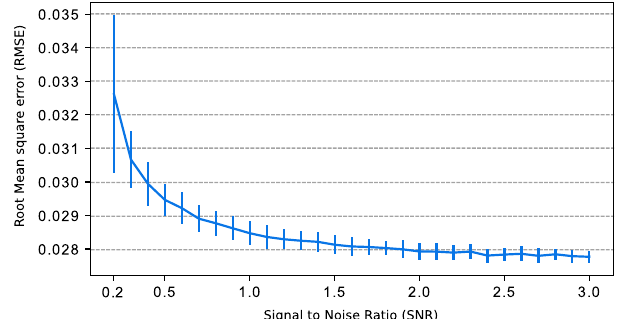
Figure 5. Graph of the Root Mean Square Error (RMSE) and standard deviation (vertical bars) for SNR levels from 0.3 to 3. The mean and standard deviation of the RMSE was taken from 100 different realizations for each level of SNR.